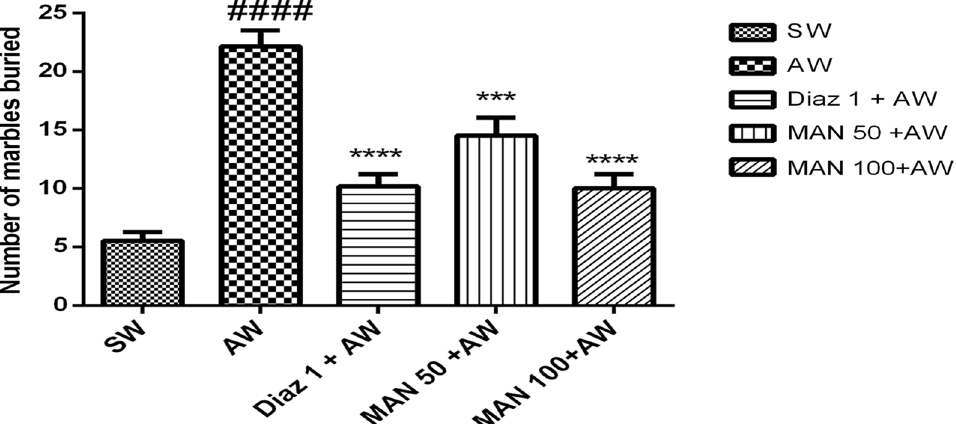
Fig. 4 Effect of MAN (50 and 100 mg/kg p.o.) on alcohol withdrawal-induced marble burying in mice. No. of marbles buried was expressed as MEAN SEM ( n 6); #### P < 0.0001 when compared with the saline withdrawal group; *** P < 0.001 and **** P < 0.0001 when compared with the ± = alcohol withdrawal